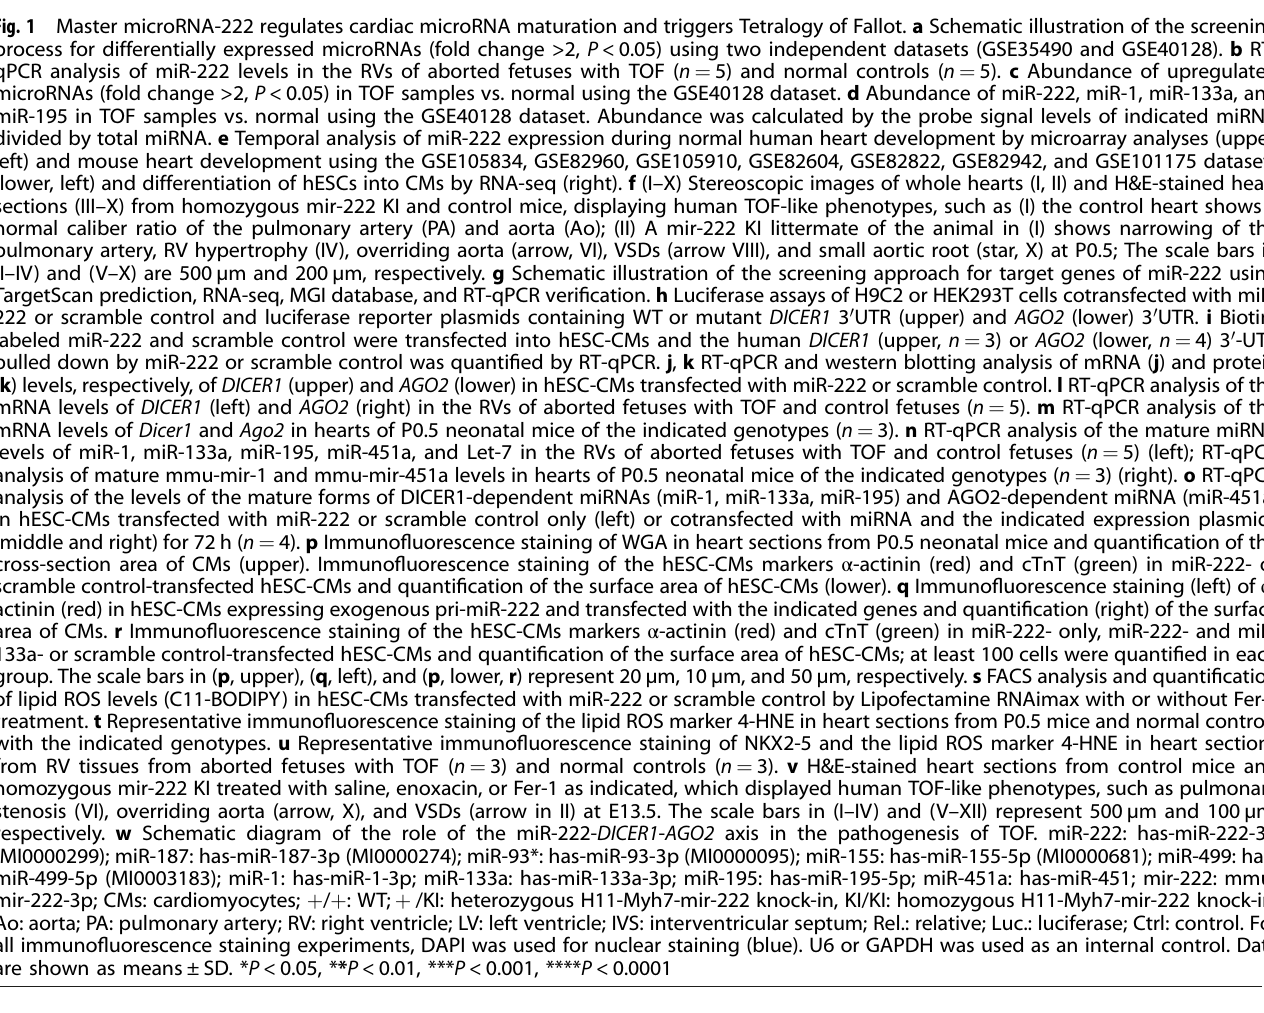
Fig. 1 Master microRNA-222 regulates cardiac microRNA maturation and triggers Tetralogy of Fallot. a Schematic illustration of the screening process for differentially expressed microRNAs (fold change >2, P < 0.05) using two independent datasets (GSE35490 and GSE40128). b RT- qPCR analysis of miR-222 levels in the RVs of aborted fetuses with TOF ( n = 5) and normal controls ( n = 5). c Abundance of upregulated microRNAs (fold change >2, P < 0.05) in TOF samples vs. normal using the GSE40128 dataset. d Abundance of miR-222, miR-1, miR-133a, and miR-195 in TOF samples vs. normal using the GSE40128 dataset. Abundance was calculated by the probe signal levels of indicated miRNA divided by total miRNA. e Temporal analysis of miR-222 expression during normal human heart development by microarray analyses (upper, left) and mouse heart development using the GSE105834, GSE82960, GSE105910, GSE82604, GSE82822, GSE82942, and GSE101175 datasets (lower, left) and differentiation of hESCs into CMs by RNA-seq (right). f (I – X) Stereoscopic images of whole hearts (I, II) and H&E-stained heart sections (III – X) from homozygous mir-222 KI and control mice, displaying human TOF-like phenotypes, such as (I) the control heart shows a normal caliber ratio of the pulmonary artery (PA) and aorta (Ao); (II) A mir-222 KI littermate of the animal in (I) shows narrowing of the pulmonary artery, RV hypertrophy (IV), overriding aorta (arrow, VI), VSDs (arrow VIII), and small aortic root (star, X) at P0.5; The scale bars in (I – IV) and (V – X) are 500 µm and 200 µm, respectively. g Schematic illustration of the screening approach for target genes of miR-222 using TargetScan prediction, RNA-seq, MGI database, and RT-qPCR veri fi cation. h Luciferase assays of H9C2 or HEK293T cells cotransfected with miR- 222 or scramble control and luciferase reporter plasmids containing WT or mutant DICER1 3 ′ UTR (upper) and AGO2 (lower) 3 ′ UTR. i Biotin- labeled miR-222 and scramble control were transfected into hESC-CMs and the human DICER1 (upper, n = 3) or AGO2 (lower, n = 4) 3 ′ -UTR pulled down by miR-222 or scramble control was quanti fi ed by RT-qPCR. j , k RT-qPCR and western blotting analysis of mRNA ( j ) and protein ( k ) levels, respectively, of DICER1 (upper) and AGO2 (lower) in hESC-CMs transfected with miR-222 or scramble control. l RT-qPCR analysis of the mRNA levels of DICER1 (left) and AGO2 (right) in the RVs of aborted fetuses with TOF and control fetuses ( n = 5). m RT-qPCR analysis of the mRNA levels of Dicer1 and Ago2 in hearts of P0.5 neonatal mice of the indicated genotypes ( n = 3). n RT-qPCR analysis of the mature miRNA levels of miR-1, miR-133a, miR-195, miR-451a, and Let-7 in the RVs of aborted fetuses with TOF and control fetuses ( n = 5) (left); RT-qPCR analysis of mature mmu-mir-1 and mmu-mir-451a levels in hearts of P0.5 neonatal mice of the indicated genotypes ( n = 3) (right). o RT-qPCR analysis of the levels of the mature forms of DICER1-dependent miRNAs (miR-1, miR-133a, miR-195) and AGO2-dependent miRNA (miR-451a) in hESC-CMs transfected with miR-222 or scramble control only (left) or cotransfected with miRNA and the indicated expression plasmids (middle and right) for 72 h ( n = 4). p Immuno fl uorescence staining of WGA in heart sections from P0.5 neonatal mice and quanti fi cation of the cross-section area of CMs (upper). Immuno fl uorescence staining of the hESC-CMs markers α -actinin (red) and cTnT (green) in miR-222- or scramble control-transfected hESC-CMs and quanti fi cation of the surface area of hESC-CMs (lower). q Immuno fl uorescence staining (left) of α